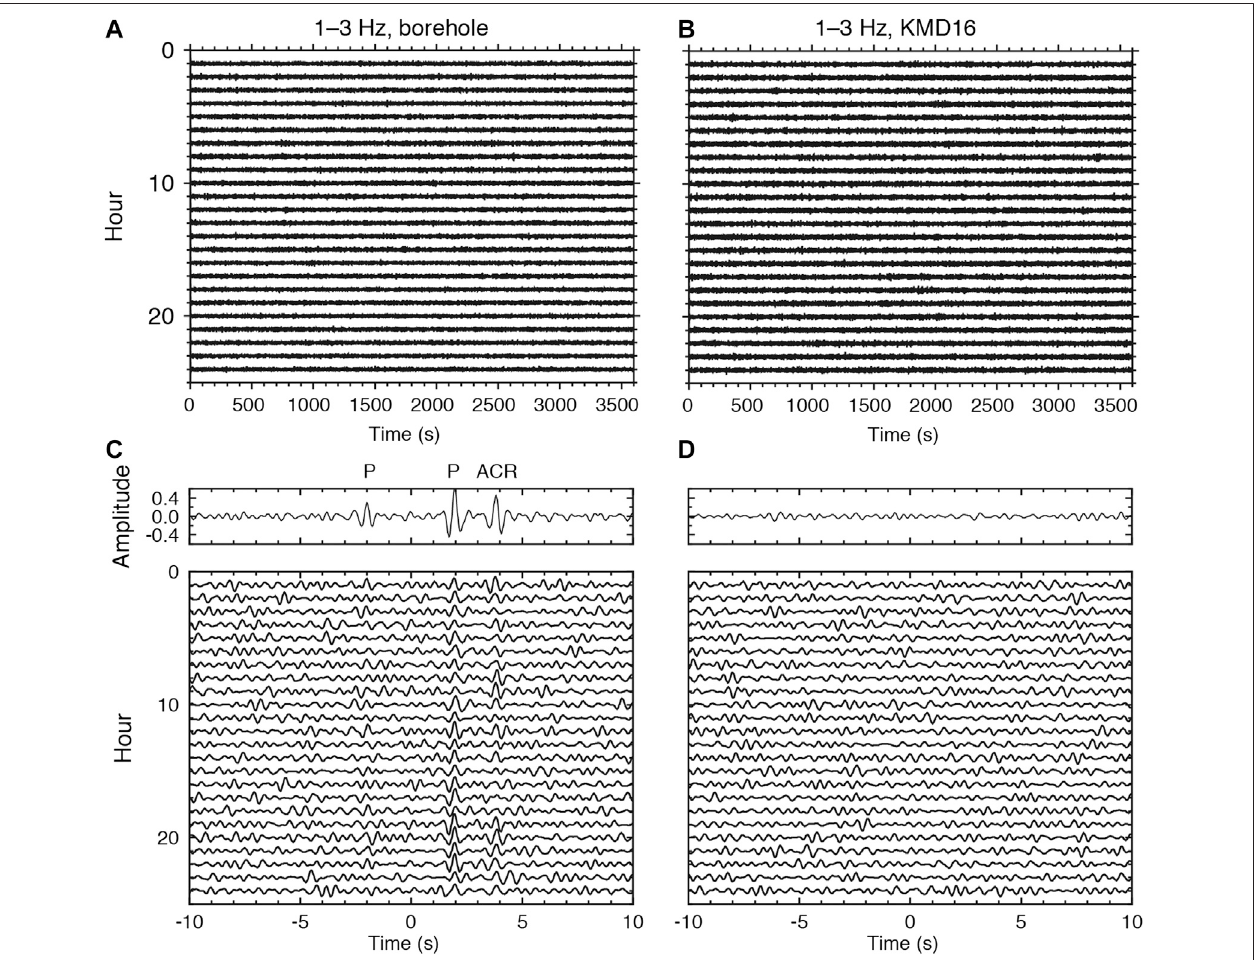
FIGURE2| Waveformexamplesrecordedwithboreholeandsea fl oorsensors. (A) One-hourrecordsoftheverticalcomponentat1 – 3 Hzobservedattheborehole sensor on February 9, 2016. (B) Same as (A) , but for KMD16. (C) One-hour CCFs using the waveforms in (A,B) , with the borehole as the reference site. The top panel represents the CCF stacked over the CCFs in the bottom panel. (D) Same as (C) , but for applying a one-bit normalization to the waveforms in (A,B) .